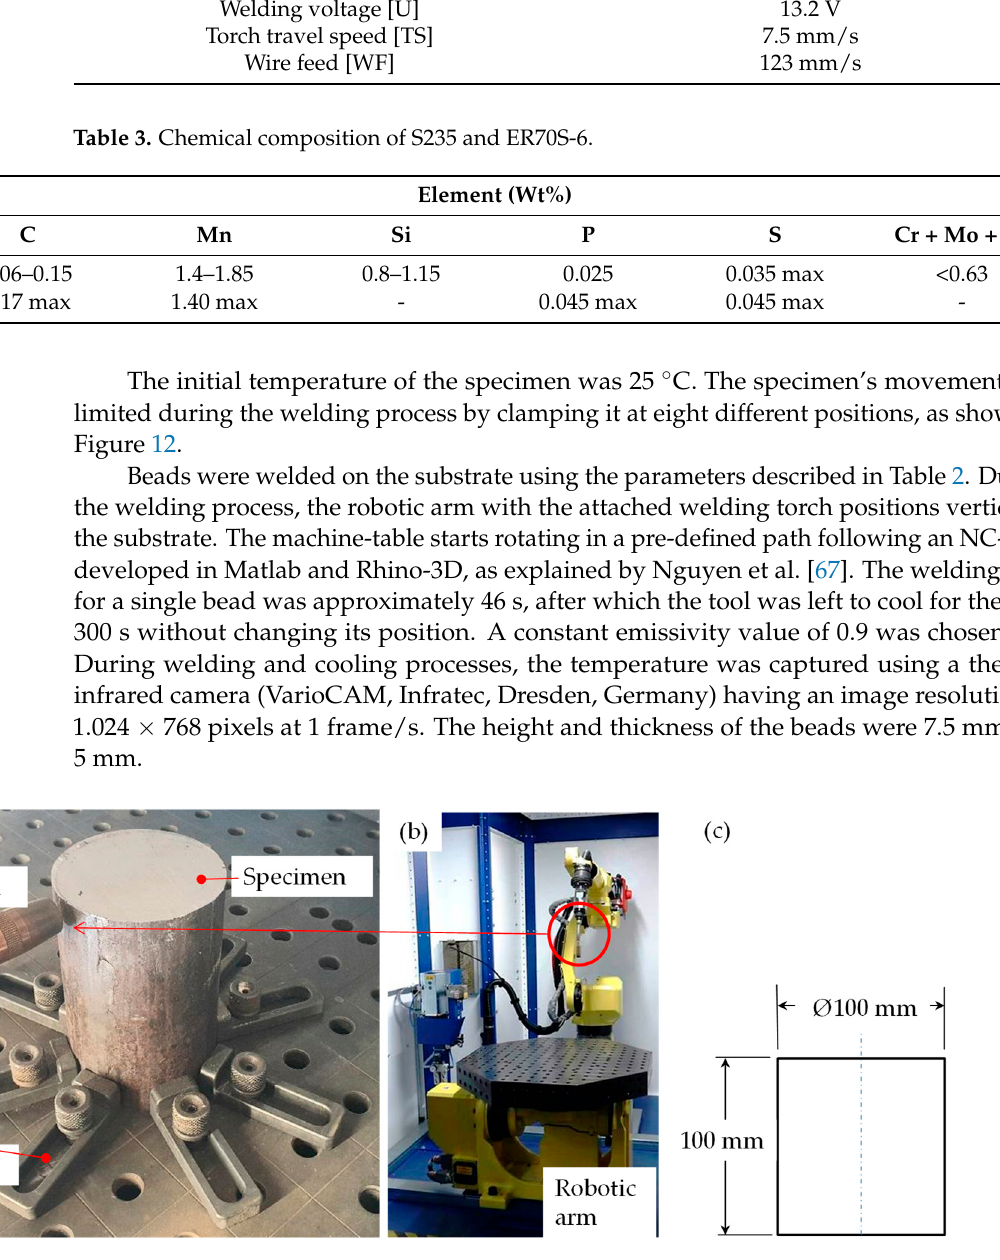
Figure 12. Arc welding setup with the mounted specimen ( a ), welding robot arm ( b ), and specimen geometry ( c ). geometry ( c